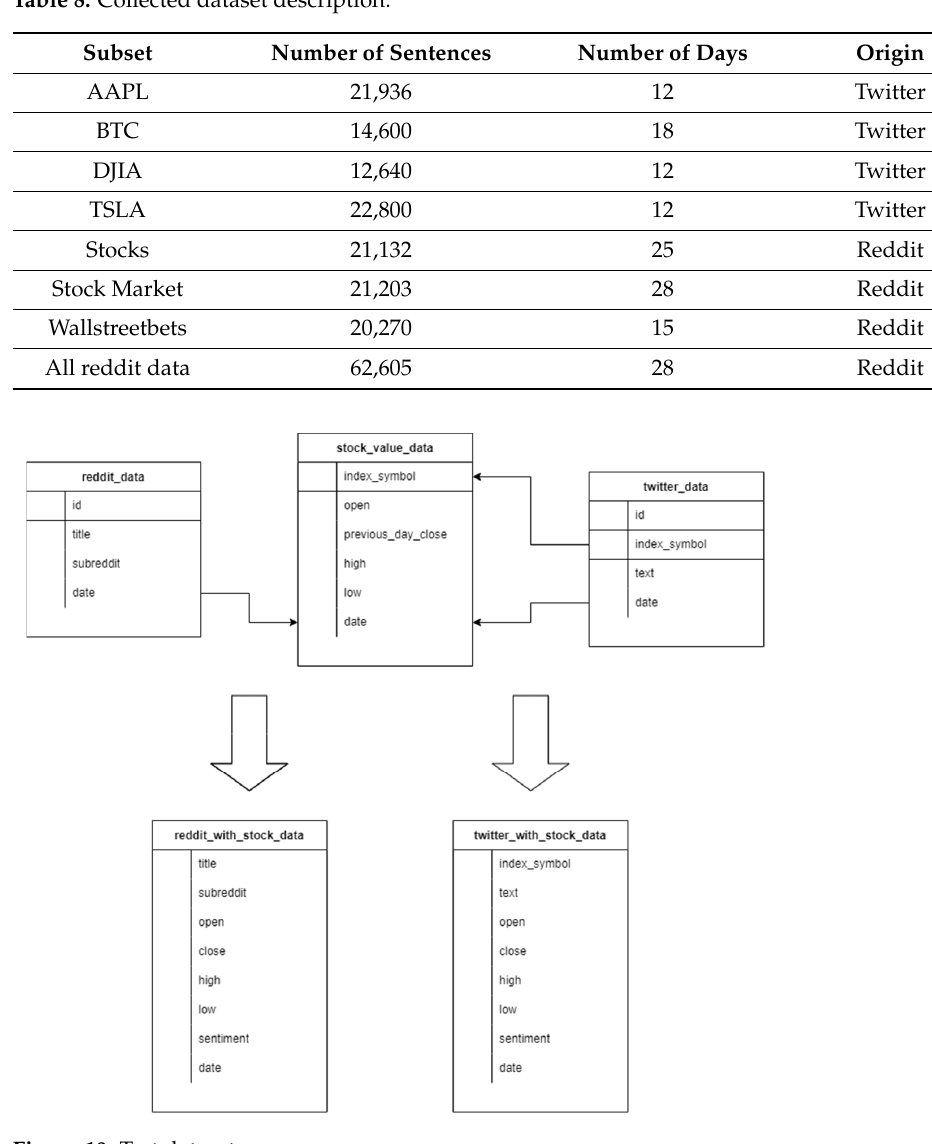
Table 8. Collected dataset description.